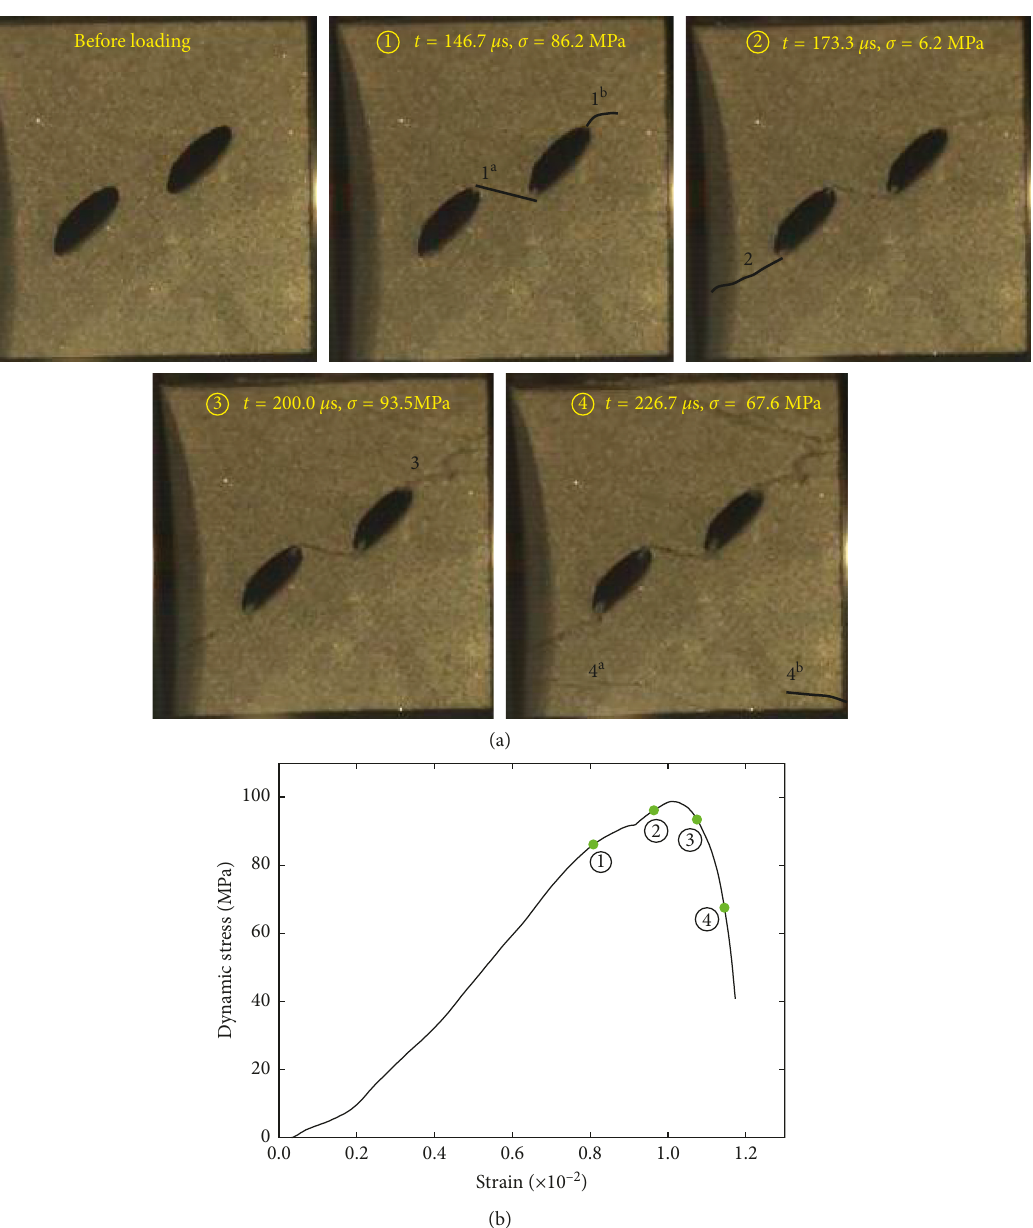
Figure 17: Fracturing process of type II mode with its corresponding dynamic stress-strain curve ( α